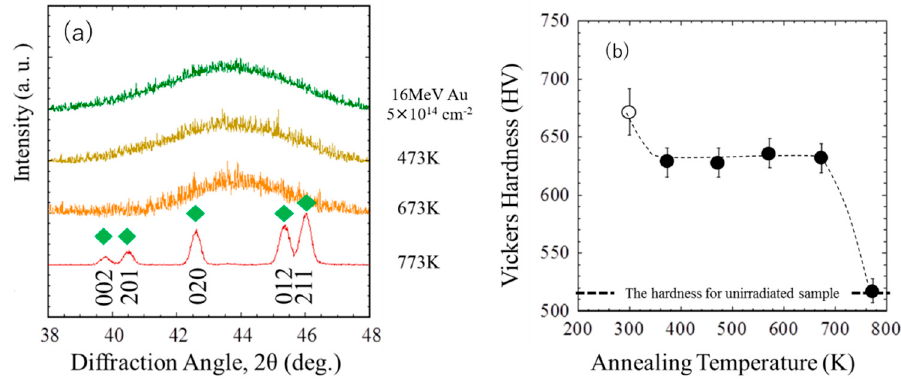
Figure 29. Effect of thermal treatment of Ni 3 Nb for ( a ) GIXD spectra and ( b ) Vickers hardness. Thermal treatment temperatures are shown at the right side of Figure 29a. The open circle in Figure 29b indicates the hardness value before thermal treatment. The hardness for unirradiated specimen is also shown in Figure 29b.